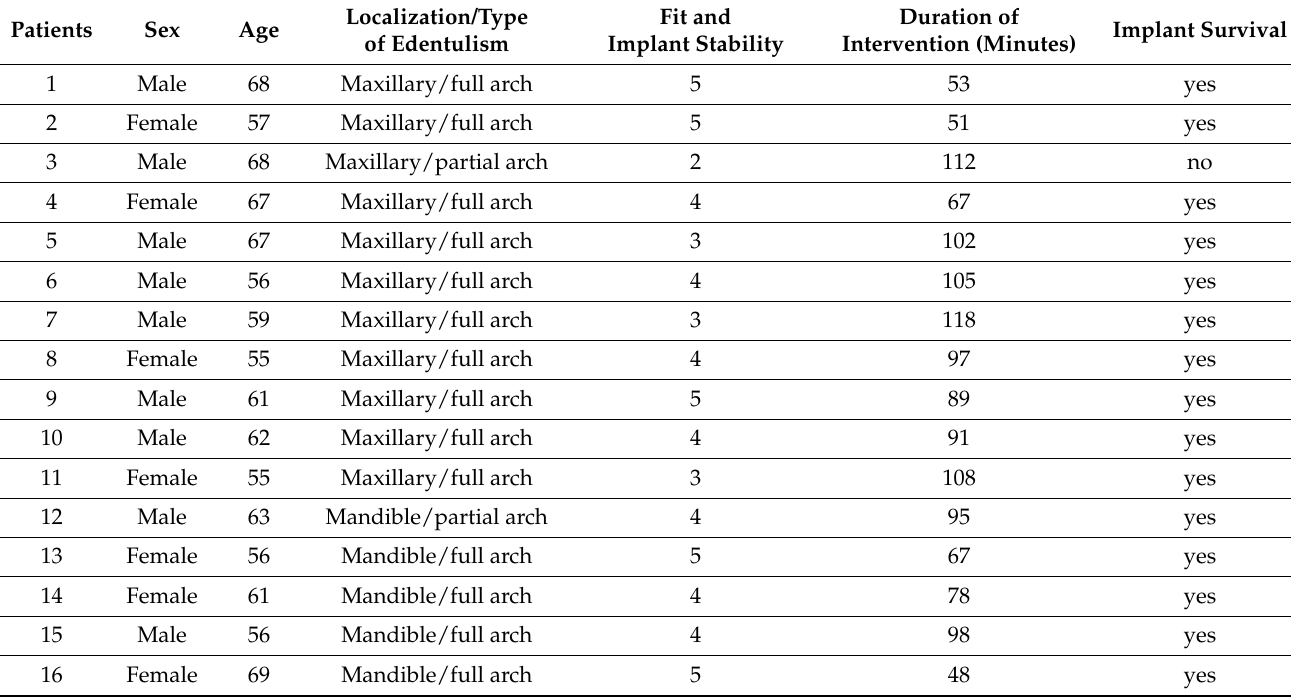
Table 1. The study outcomes referred to patient and implant